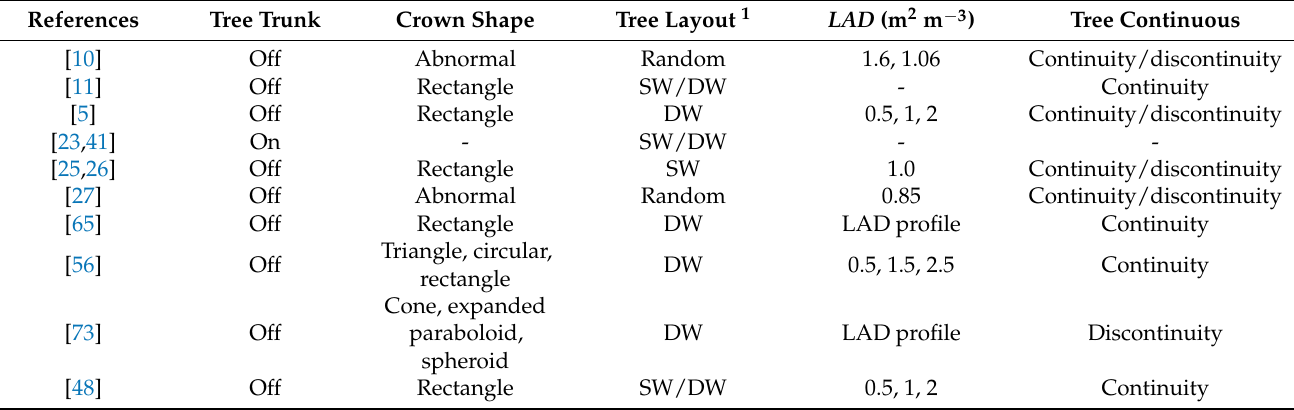
Table 2. Studies on tree factors by different